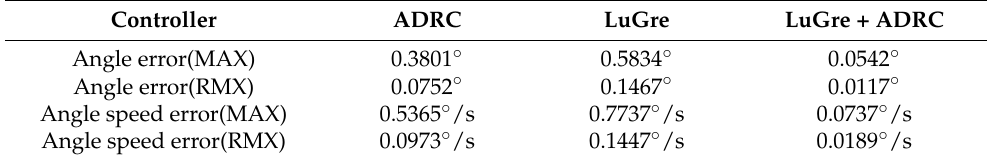
Figure 8. Multiple sinusoidal trajectory tracking results. ( a ) Diagram of the angle tracking curve; ( b ) Diagram of the angle error curve; ( c ) Diagram of the angle speed tracking curve; ( d ) Diagram of the angle speed error curve. Table 3. Comparison of angle tracking error and angle speed error under multiple sinusoidal input signals.